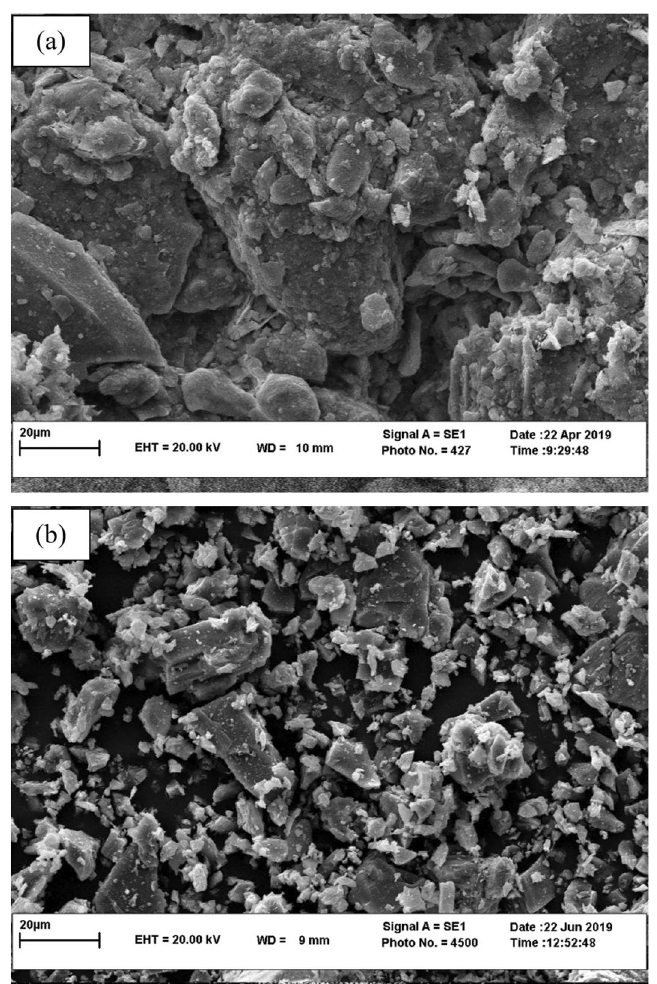
Figure 3. SEM micrographs of used materials; ( a ) clayey soil, ( b ) volcanic ash